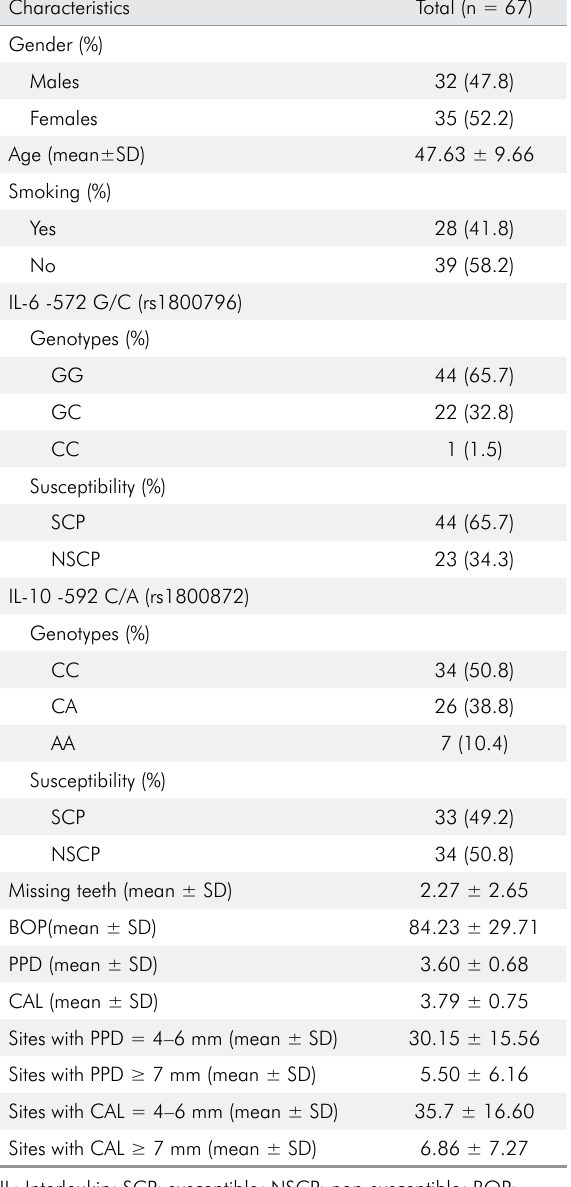
Table 1. Demographic characteristics, genotype and periodontal status of the included